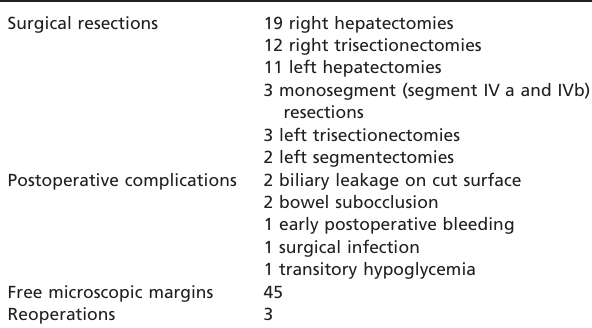
Table 3 - Main results of children submitted for surgical resection of